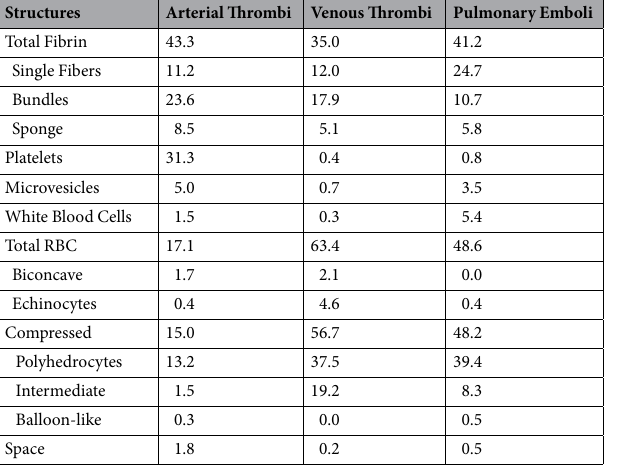
Table 1. The average volume fraction (%) of structures identified in arterial and venous thrombi and pulmonary